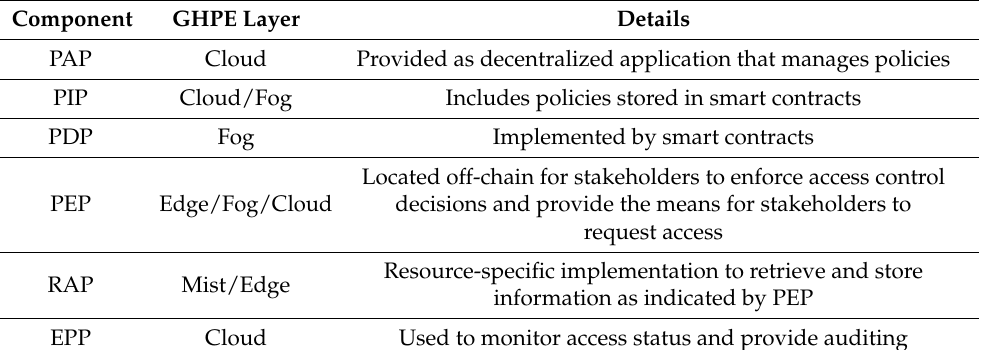
Table 2. NGAC components placement in GHPE